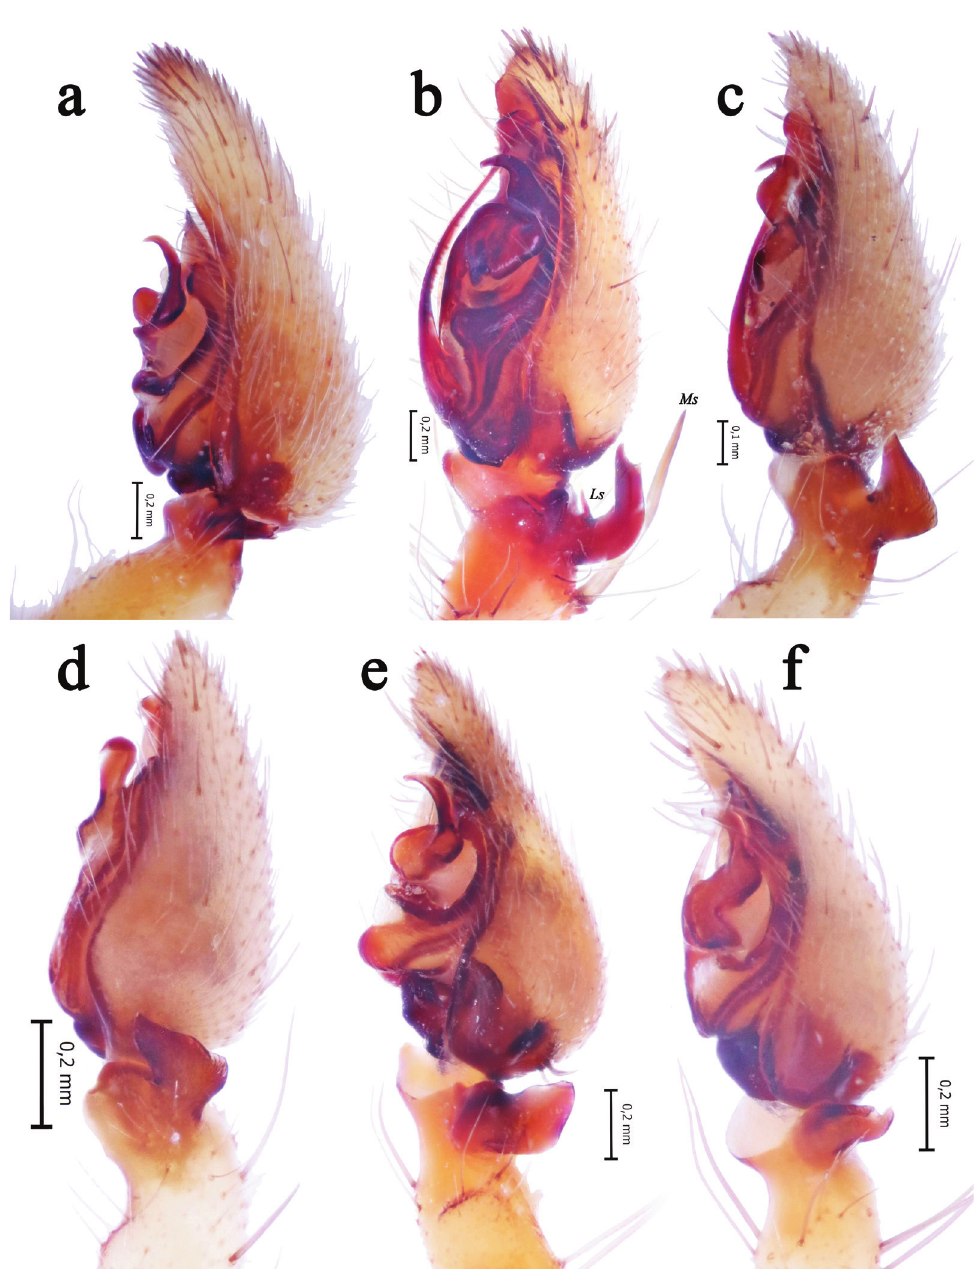
Figure 3. Retrolateral views of the male palps of Pterotricha spp.: a ) P. arabica sp. n.; b ) P. esyunini sp. n.; c ) P. nadolnyi sp.